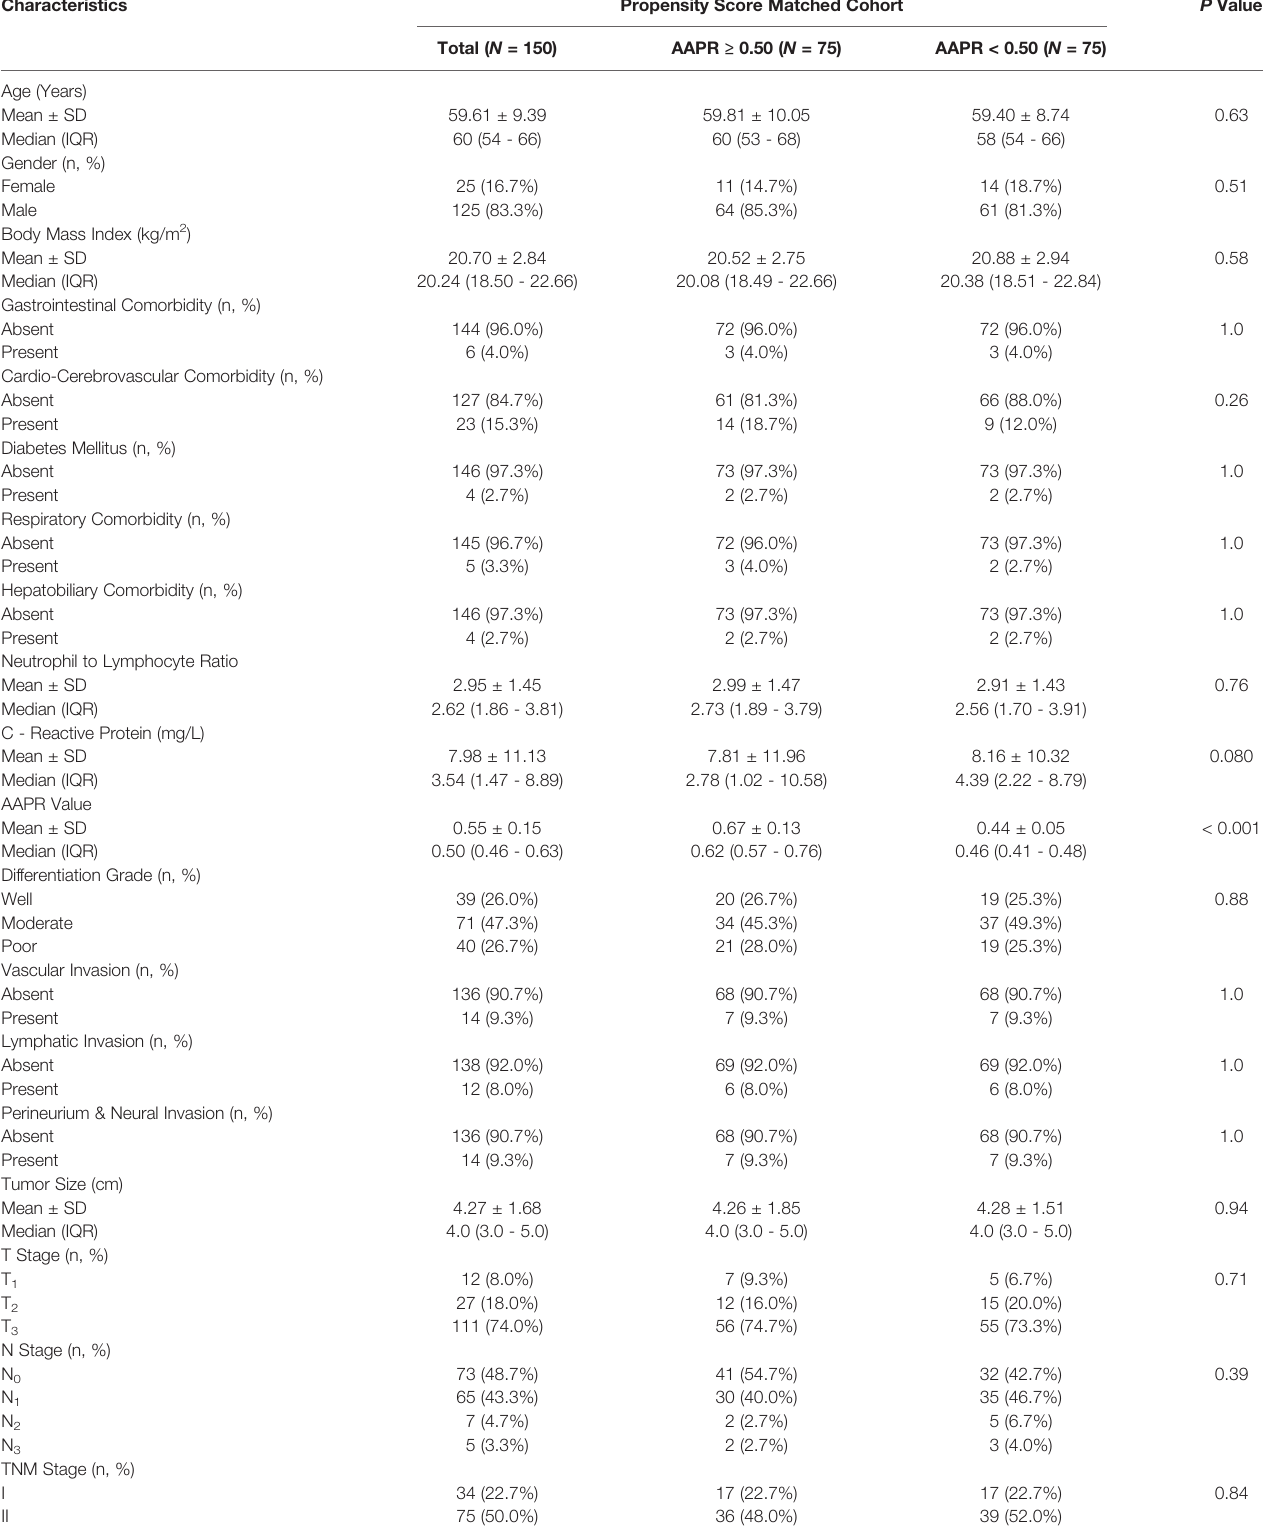
TABLE 3 | Patient characteristics and in-hospital outcomes of the propensity score matched cohort.